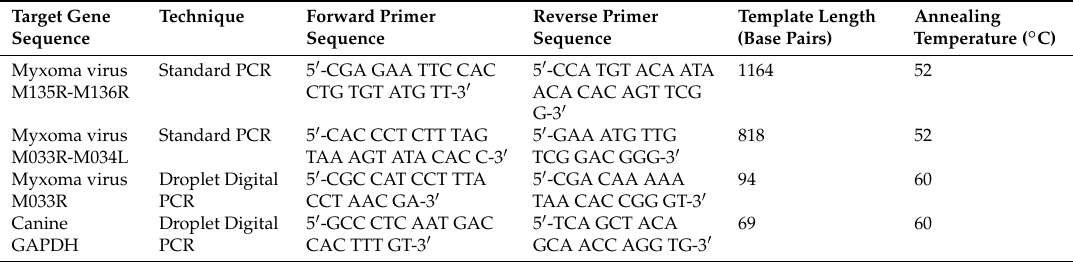
Primers designed to detect myxoma virus and canine glyceraldehyde 3-phosphate dehydrogenase (cGAPDH) DNA in canine tissues (blood, urine, feces, tumor biopsies) and on swabs (buccal and tumor